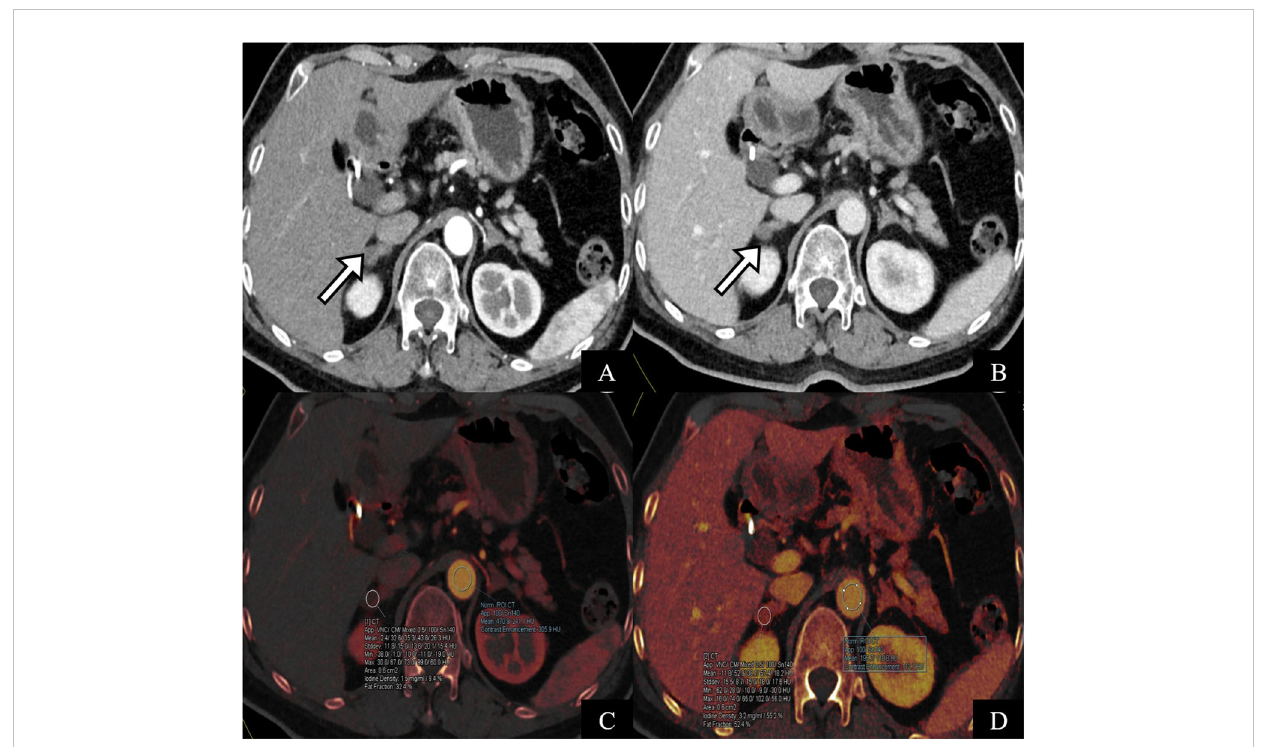
FIGURE 5 A 64-year-old female patient with surgically pathologically con fi rmed of primary hyperaldosteronism. The CT scan of the adrenal glands showed soft tissue density of nodular adrenal glands bilaterally (A, B) pointed by white arrow). AVS indicated high secretion of aldosterone on the right side. (C, D) are iodine maps of the arterial phase. The iodine concentration in the arterial and venous phases was 1.7 mg/ml and 0.61 mg/ml, respectively, and the ICD was 1.09 mg/ml, which is consistent with the diagnosis of the right dominant side of AVS.